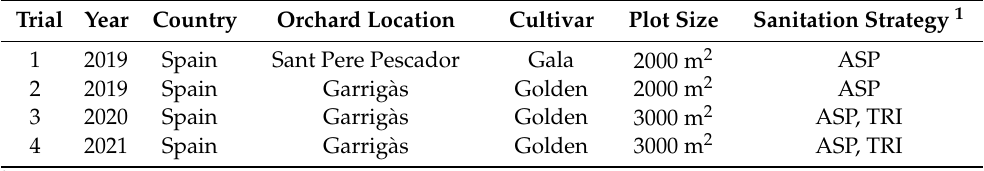
Table 1. Characteristics of trials performed for evaluating the effect of different sanitation treatments aimed at controlling Alternaria fruit spot of